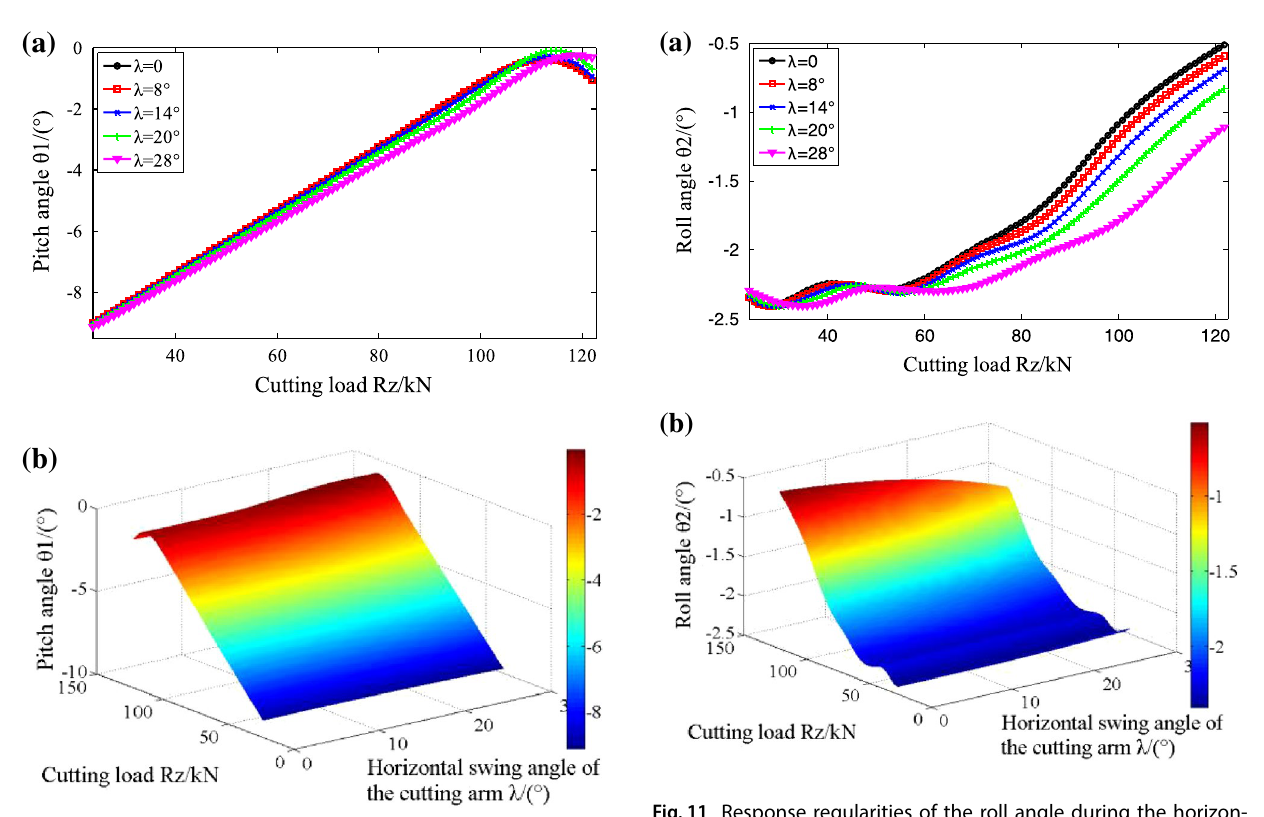
Fig. 10 Response regularities of the pitch angle during the horizon- tal cutting process. ( a ) Relationship between the pitch angle and the cutting load. ( b ) Relationship of the pitch angle, cutting load and horizontal swing angle of the cutting arm